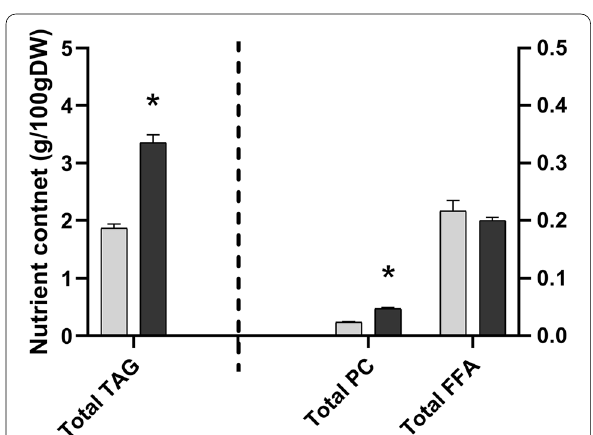
Fig. 11 Lipid composition comparison. TAG content in the left panel follows the primary y‑axis ranging from 0 to 5 g/100gDW; PC and FFA content in the right panel follows the secondary y‑axis ranging from 0 to 0.5 g/100gDW (* P < 0.05; ANOVA, Tukey’s HSD test; TAG, PC, and FFA, n 3) =